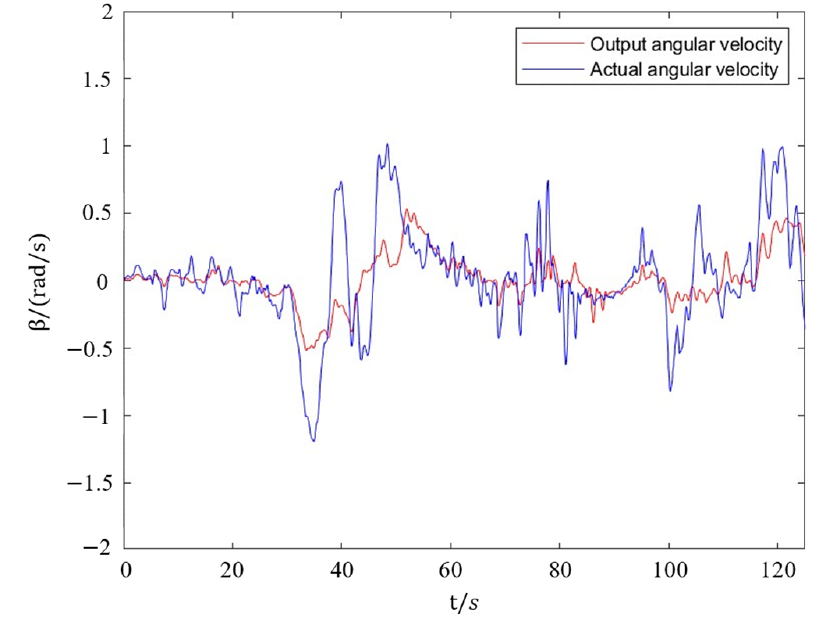
Figure 18. Platform output angular velocity.